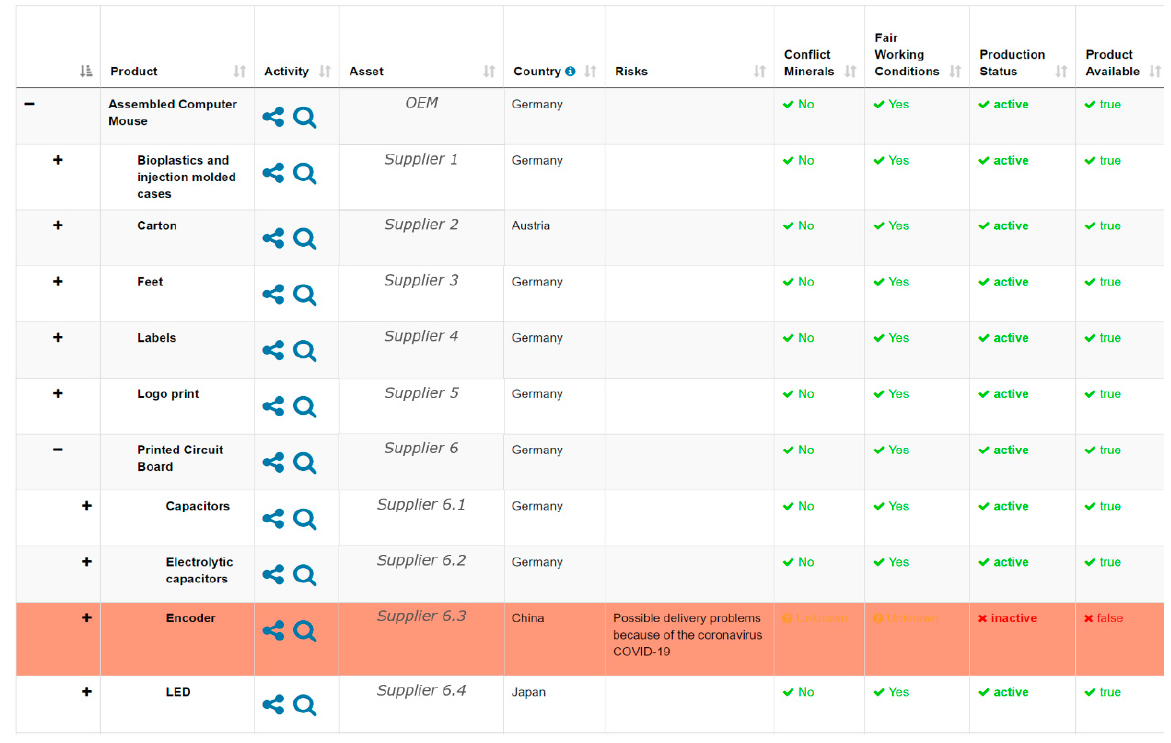
Figure 17. Supply chain and product structure of a computer mouse example.